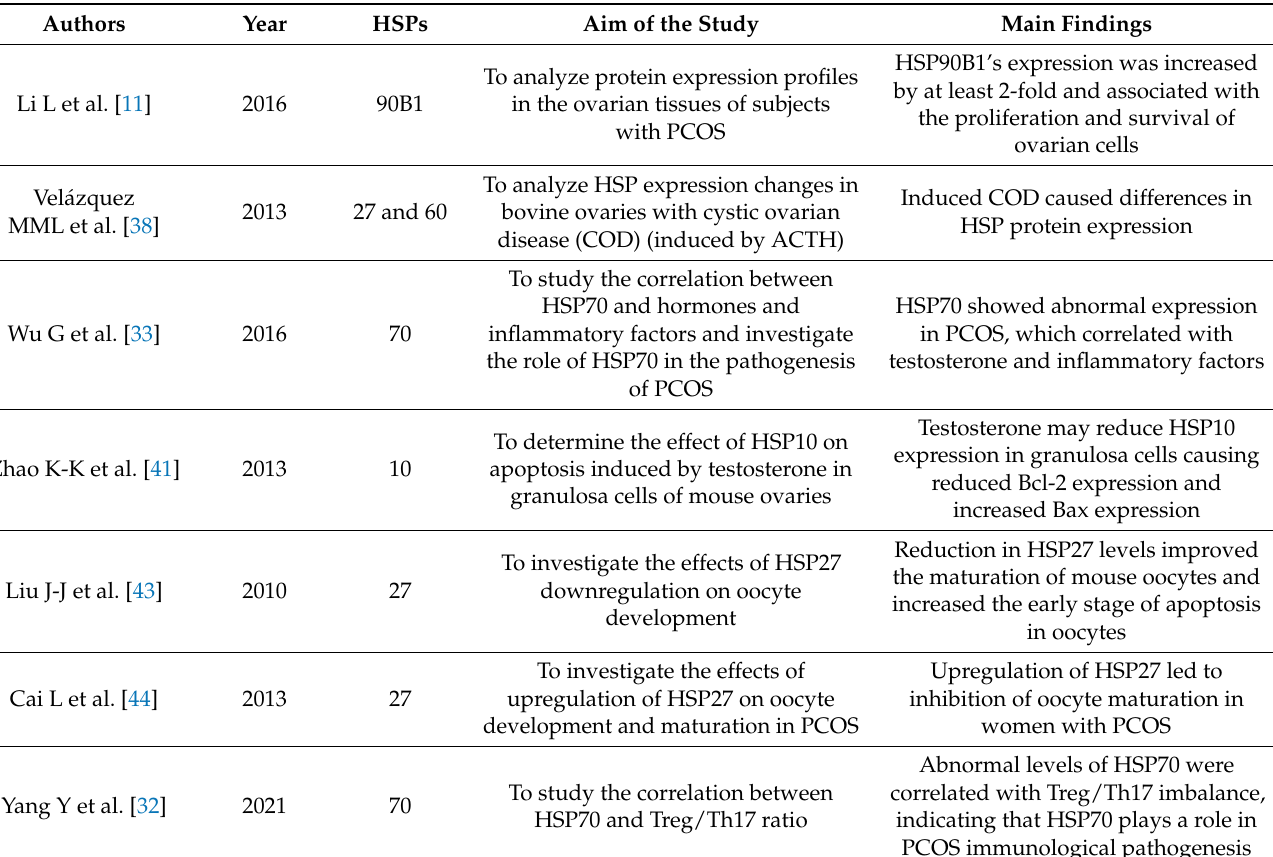
Table 1. A summary of the evidence relating to the role of HSPs in the pathogenesis of